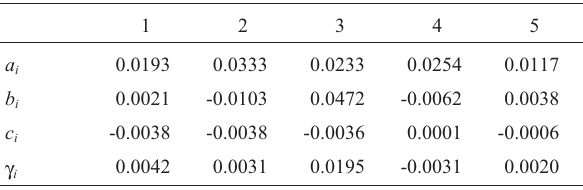
Table 2 - Deviations from the average estimates with relation to the true gene parameters.